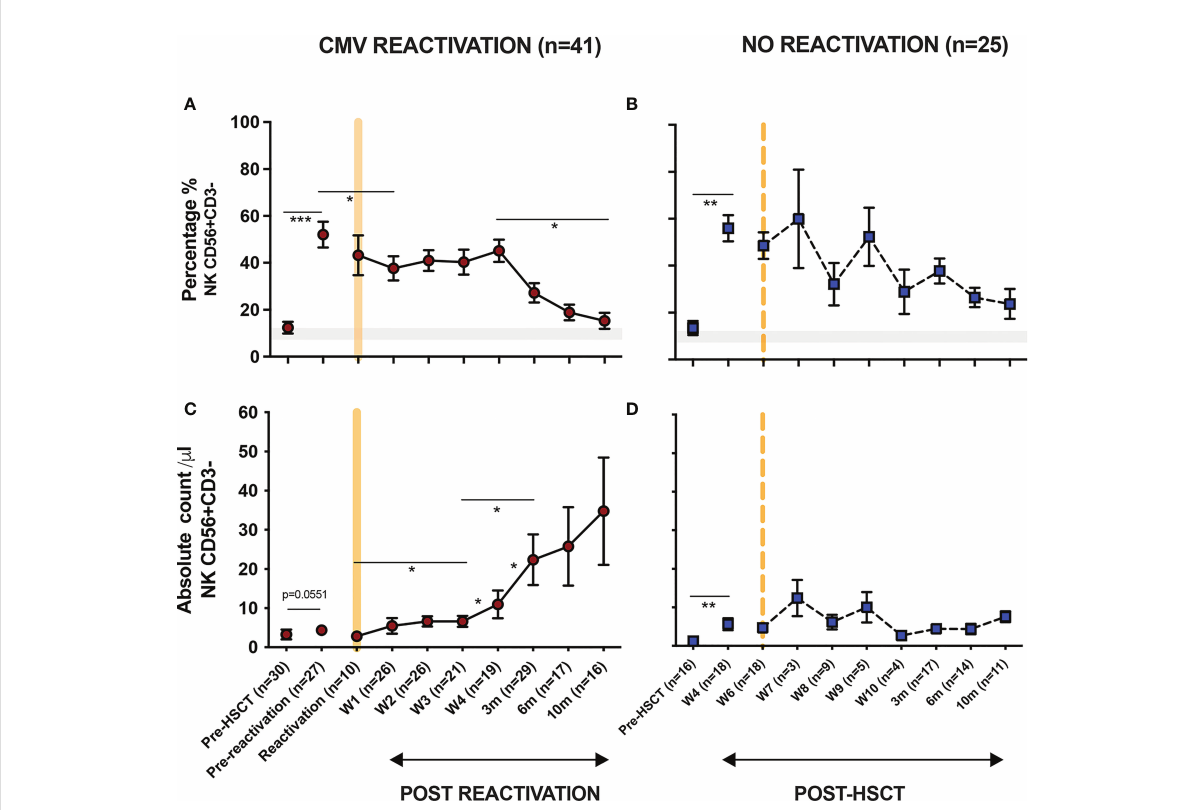
FIGURE 1 NK cells undergo long term expansion following short term CMV reactivation. The percentage and number of peripheral NK cells was measured at regular timepoints prior to, and following, an episode of CMV reactivation in patients after HSCT. Matched timepoint samples were obtained from patients without an episode of reactivation. Sample times are shown as week (W) or month (m). (A) Percentage of NK cells in patients with CMV reactivation. (B) Percentage of NK cells in patients without CMV reactivation. (C) Number of NK cells in patients with CMV reactivation. (D) Number of NK cells in patients without CMV reactivation. Patients were classi fi ed as undergoing an episode of CMV reactivation when viral load reached > 200 copies/ml. Grey line represents the percentage range of NK cells within healthy donors. (*p<0.05, **p<0.01, ***p<0.001; Wilcoxon sign rank test for matched time